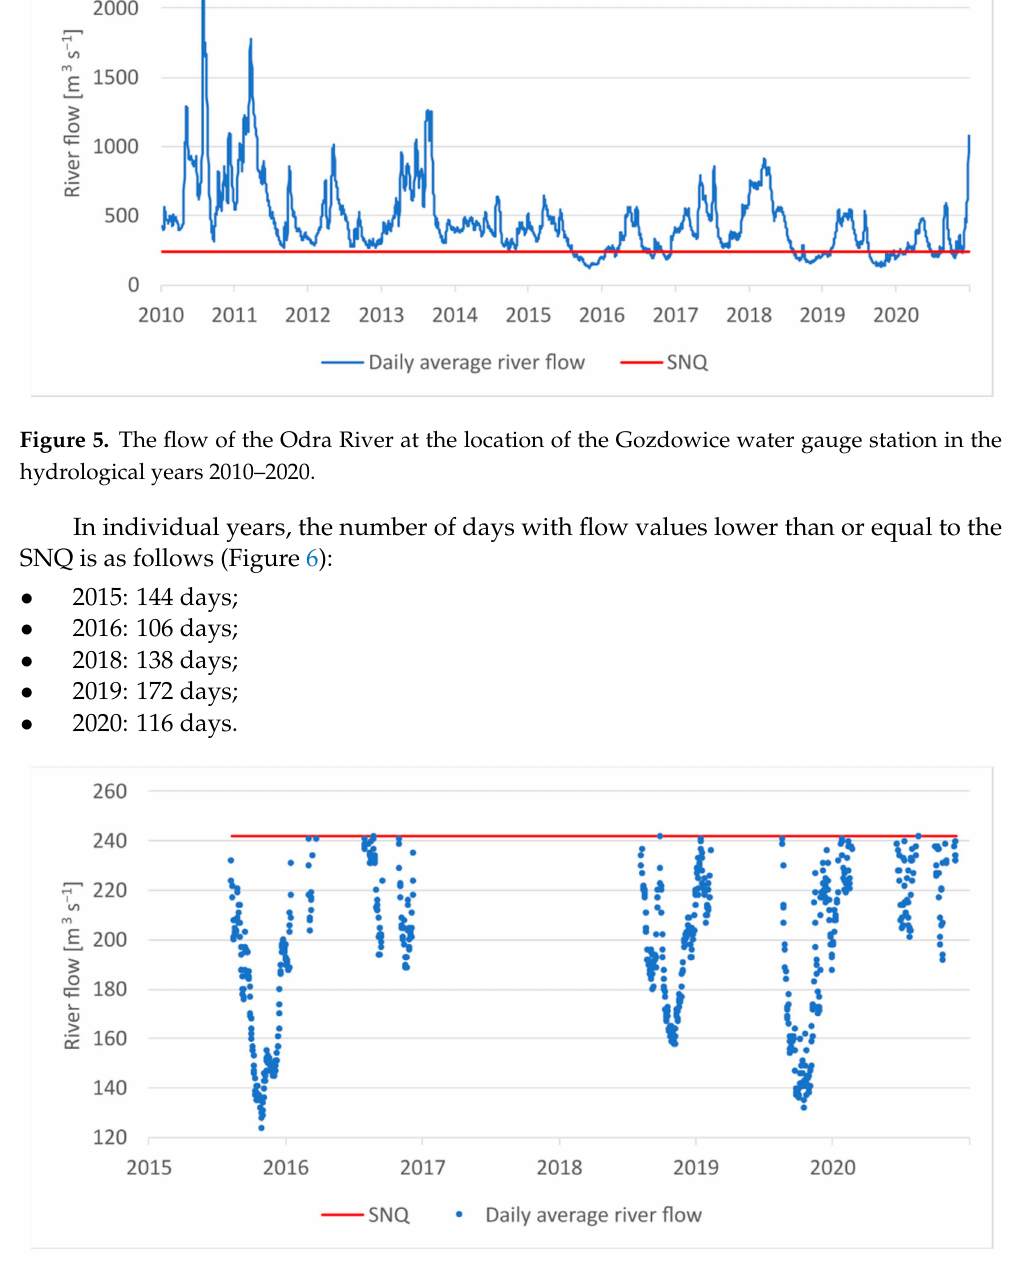
Figure 6. Flow values lower than or equal to the SNQ